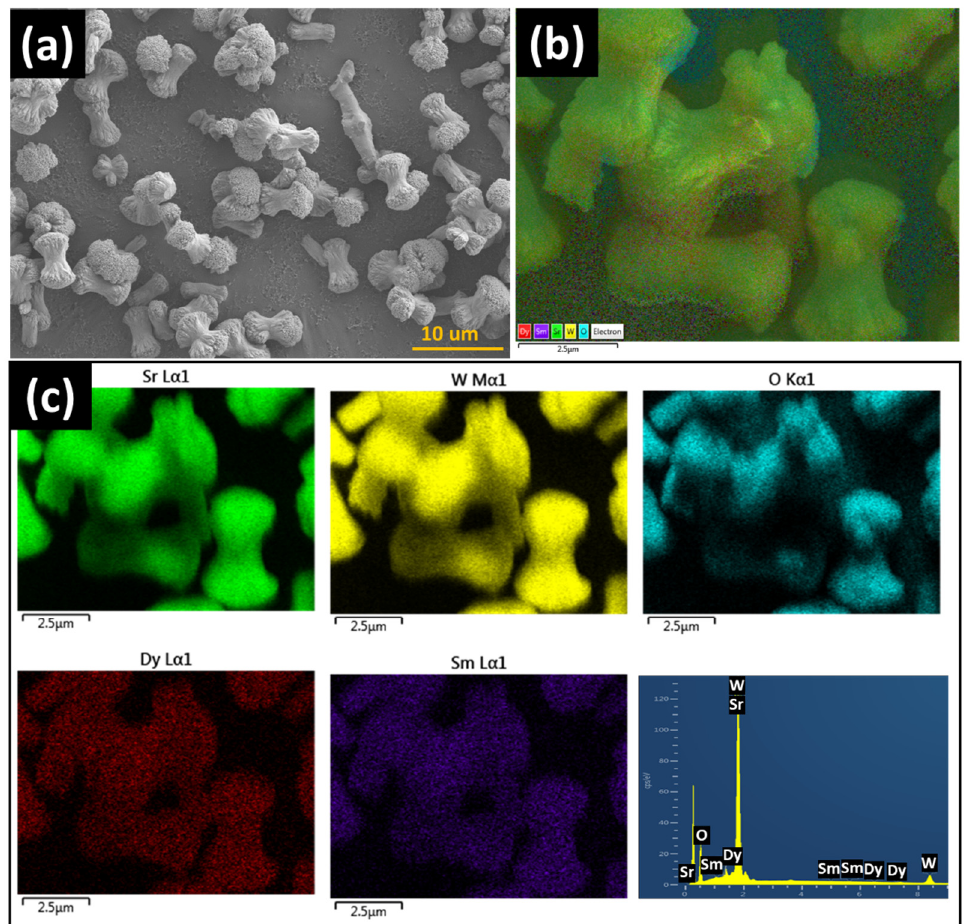
Figure 6. ( a ) FE-SEM image of SrWO 4 :[Sm 3+ ]/[Dy 3+ ], ( b ) EDS layered image, and ( c ) elemental mapping analysis.